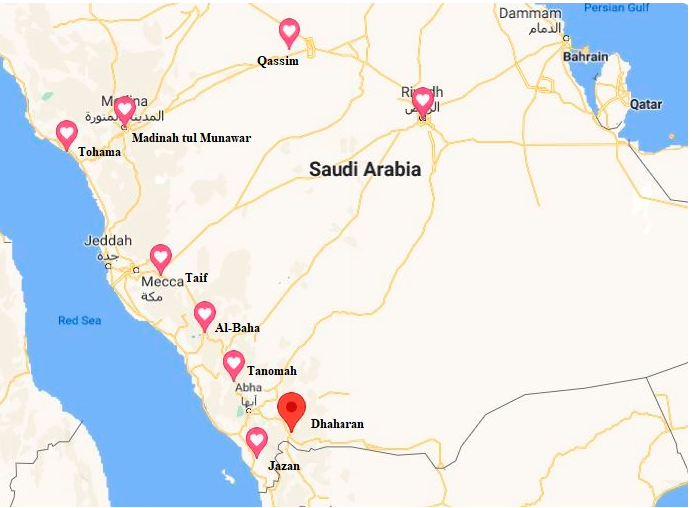
Figure 4. Saudi duckweed collection sites. The latitude (N), longitude (E), and altitude in meters of the locations are as follows: Riyadh → 24°39 ′ 31” → 46° 36 ′ 26” → 614; Dhahran → 17°40 ′ 36” → 43°20 ′ 53” → 1717; Tohama → 19°48 ′ 52.4” → 41°37 ′ 14.6” → 2070; Al ‐ Baha → 20°00 ′ 46.3” → 41°29 ′ 12” → 2103; Jazan → 17°01 ′ 56” → 43°09 ′ 04” → 947; Al ‐ Taif → 21°12 ′ 45” → 40°27 ′ 17” → 1672; Tanomah → 18°54 ′ 37.2” → 42°12 ′ 29.4” → 2228; Al ‐ Qassim → 26°24 ′ 22” → 44°01 ′ 04” → 594; Madinah ‐ 1 → 24°37 ′ 38” → 39°54 ′ 08” → 821; Madinah ‐ 2 → 24°37 ′ 38” → 39°54 ′ 08” → 821.